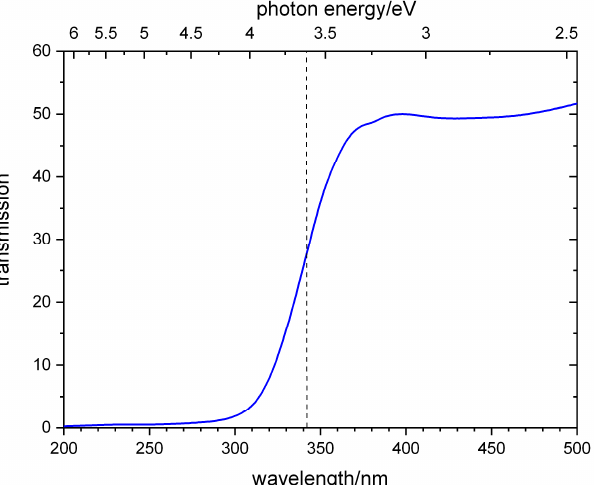
Figure 9. UV/Vis spectrum of the NiO sample (thickness 300 nm) on Si 3 N 4 corrected for substrate transmission.